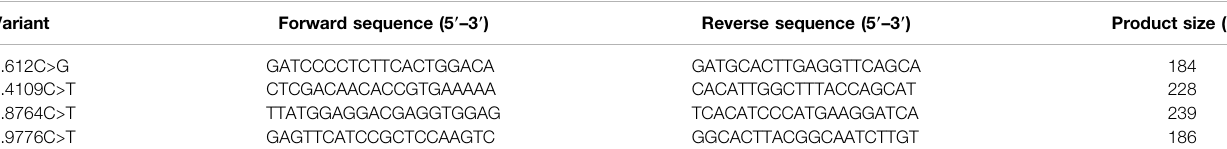
TABLE 1 | Detecting primers for the dynein axonemal heavy chain 17 gene variants. Variant